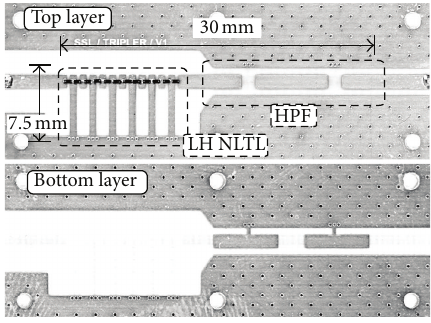
Figure 8: Picture of the fabricated tripler.